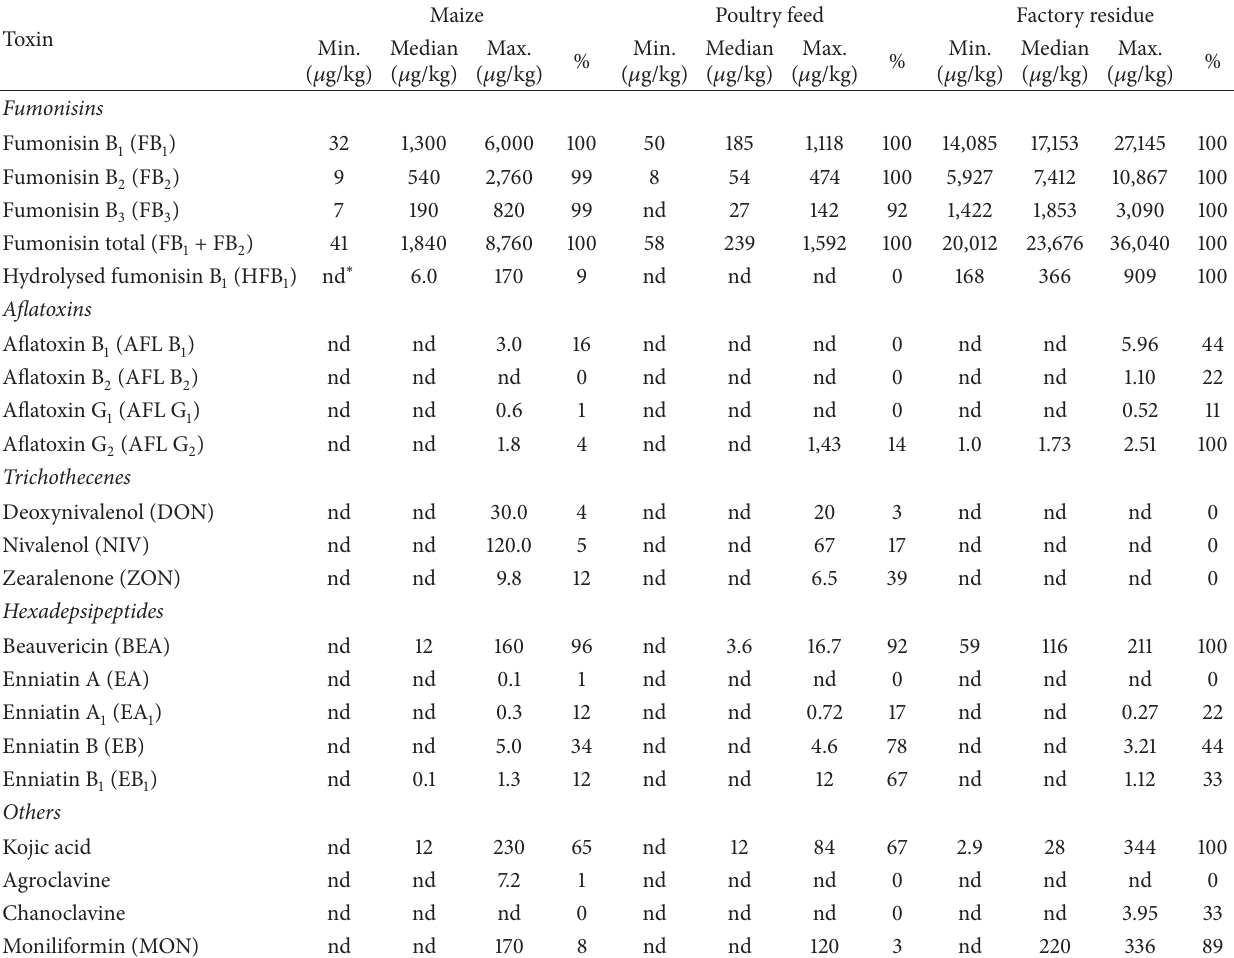
Table 2: Mycotoxins and metabolites detected in maize, poultry feed, and factory residue by liquid chromatography-tandem mass spectrometry (LC-MS/MS). It shows the contamination range, median, and percentage of contaminated samples. Maize Poultry feed Factory Toxin